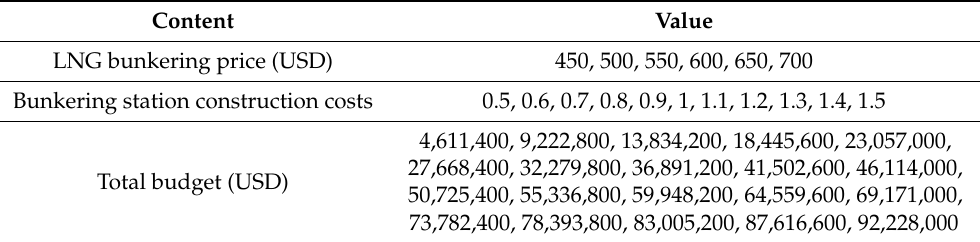
Table 2. Values of parameters for sensitive analyses.